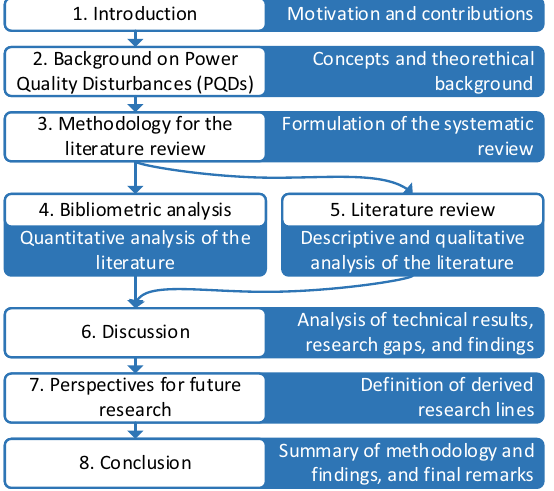
Fig. 1 Structure and logical framework of the